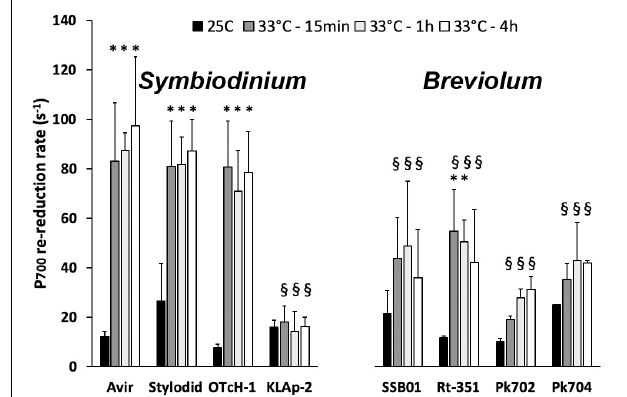
FIGURE 5 | P700 re-reduction rates in presence of DMCU in Symbiodinium and Breviolum strains. Samples were analyzed at time 0 (25 ◦ C), after 15 min, 1 h, 4 h and 24 h at 33 ◦ C. All measurements were performed on three biological replicates and data are presented as means ± SD. ∗ value differs significantly ( P < 0.05) from the control value at 25 ◦ C. § value differs significantly ( P < 0.05) from the value for Avir strain at the same timepoint.